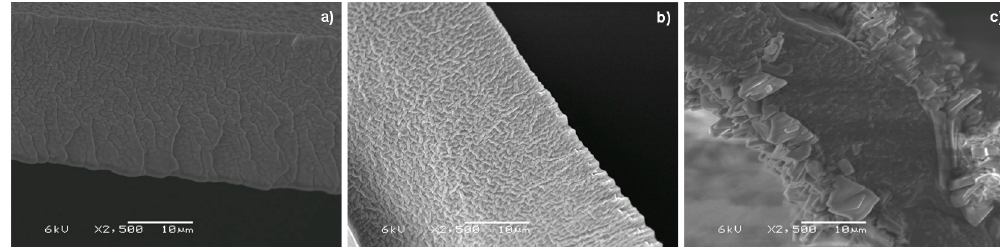
Figure 4. SEM images (magnification: 2500×) of cross-section PIMs with contents of DCH18C6 of 14.0 wt % ( a ); 24.8 wt % ( b ); and 33.2 wt % ( c ).